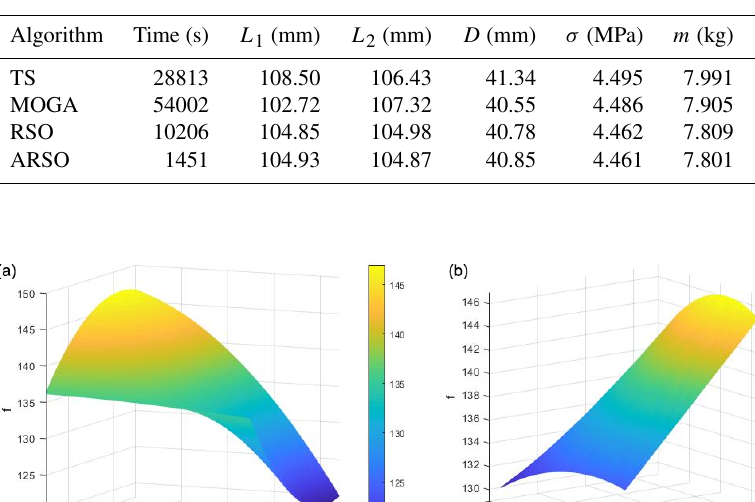
Table 6. Calculation results of the four algorithms.